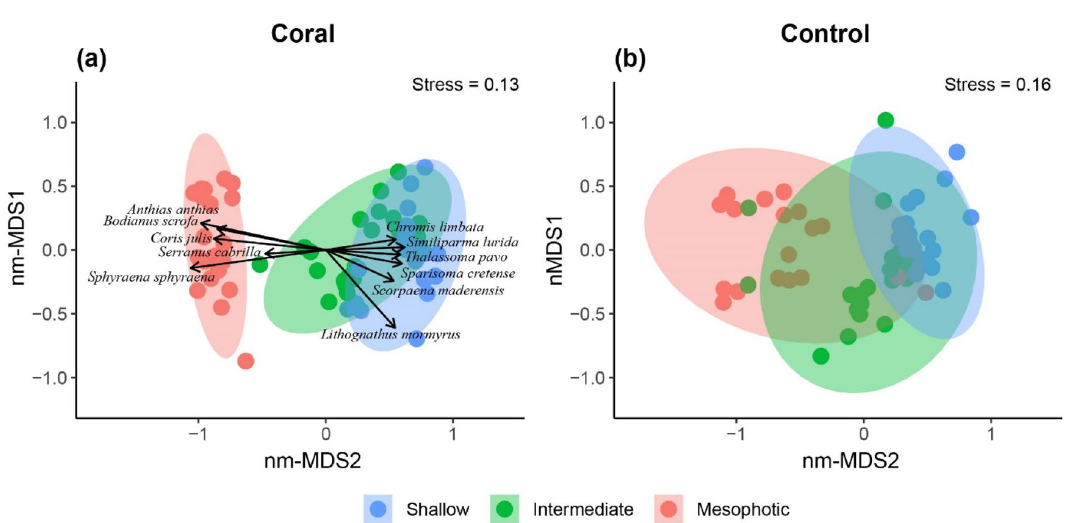
Figure 2. Non-metric multidimensional scaling (nm-MDS) biplot showing the ordination of fish assemblages in the presence or absence of BCFs (a and b, respectively) in 3 different depth strata (shallow, intermediate, and mesophotic). Colored dots depict individual UVCs transects. Confidence ellipses delineate the 95% confidence interval around the mean bivariate coordinate for each depth strata. Species varying significantly among depth strata (Table S4) are overlaid as vectors. Stress values for nm-MDS are indicated within each